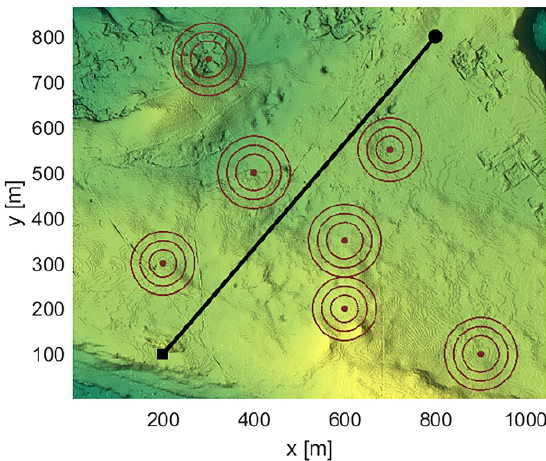
Figure 19. The top view of the path generated by the fourth set of data for the PSO algorithm.